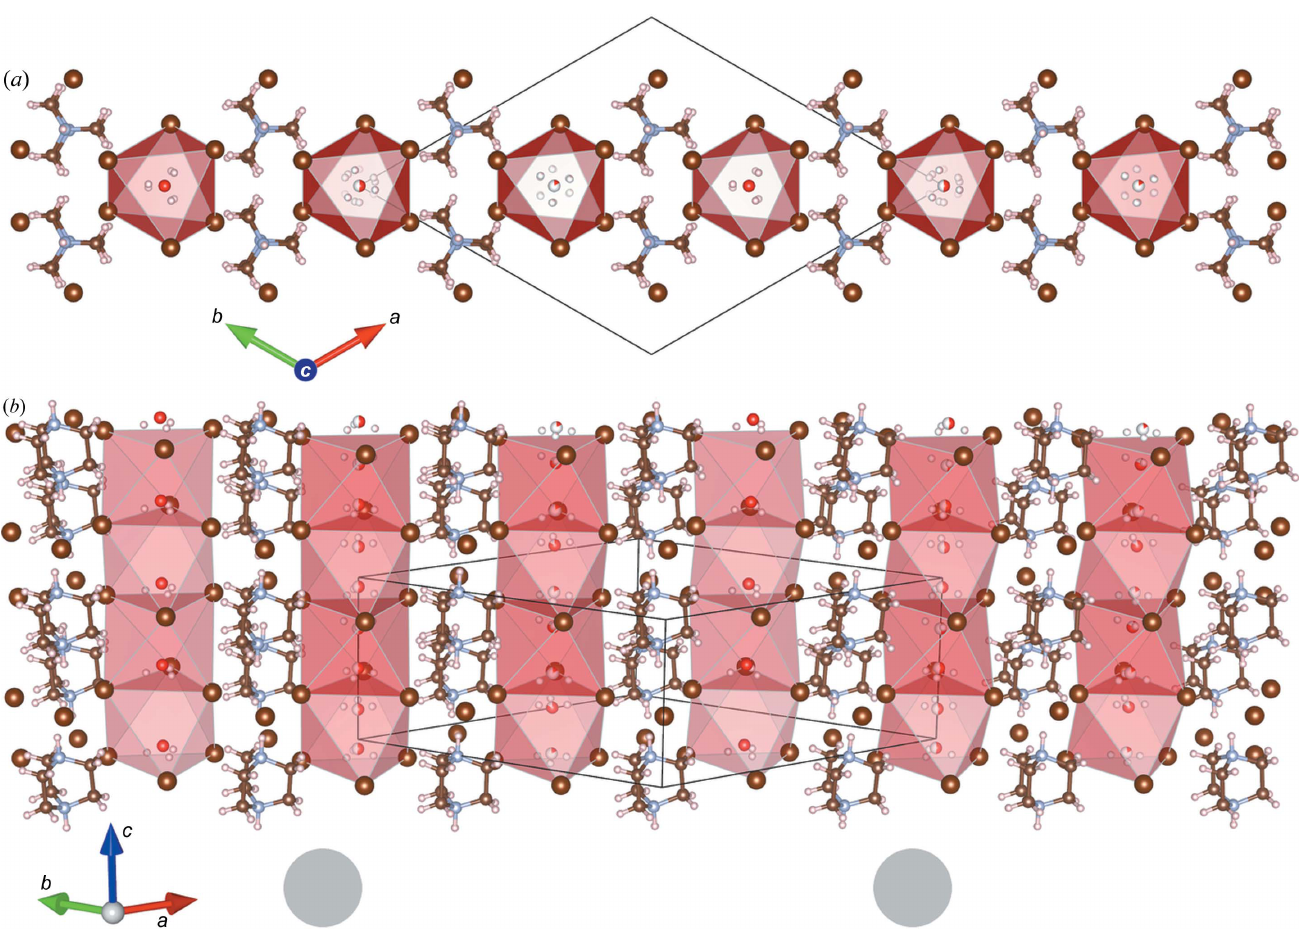
Figure 3 Polymorph (cid:3) -[dabcoH 2 ] 2+ [H 3 O] + Br (cid:2) 3 with chains of face-sharing octahedra: ( a ) parallel view along the [001] direction; and ( b ) autostereographic view (Katrusiak, 2001) comparing the columns of face-sharing octahedra – the full translational symmetry along the unit-cell diagonal across the page is indicated by two grey circles below the drawing. The colour code for atoms is the same as in Fig.